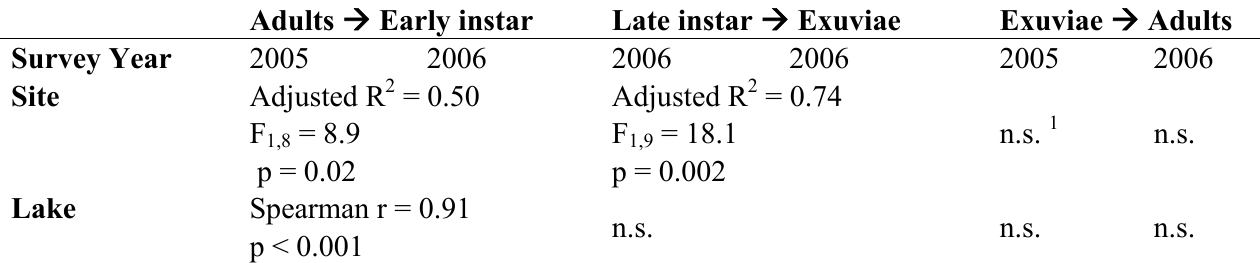
Table 4. Results from mixed-effects linear models comparing Gomphidae life stage densities among sites (n = 22) and Spearman rank correlation tests comparing life stage densities among lakes (n = 11).